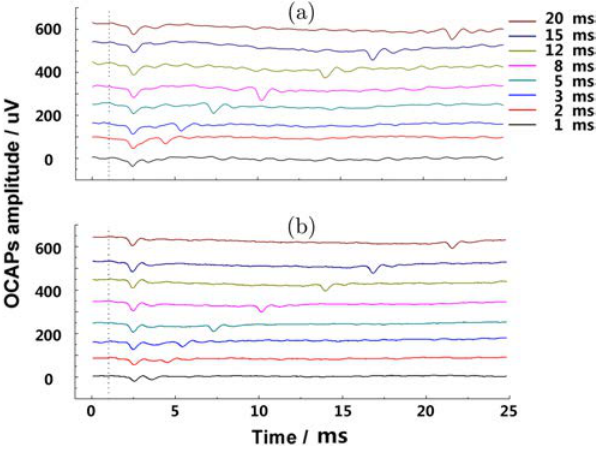
Fig. 5. OCAPs measured from the chronically. (a) acutely and (b) deafened guinea pigs. The dotted line on the left represents the starting time of acoustic stimuli. Di®erent colors stand for di®erent pulse duration under the same radiant ex- posure. OCAPs are found in each line and some of them emerge two OCAPs when pulse durations are more than 2 ms.